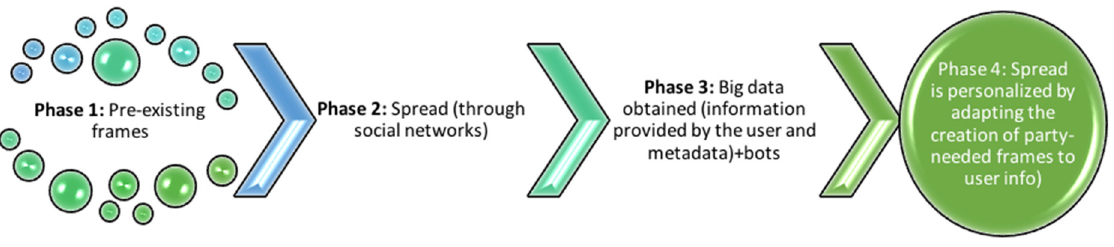
Figure 1. Source: created by authors.